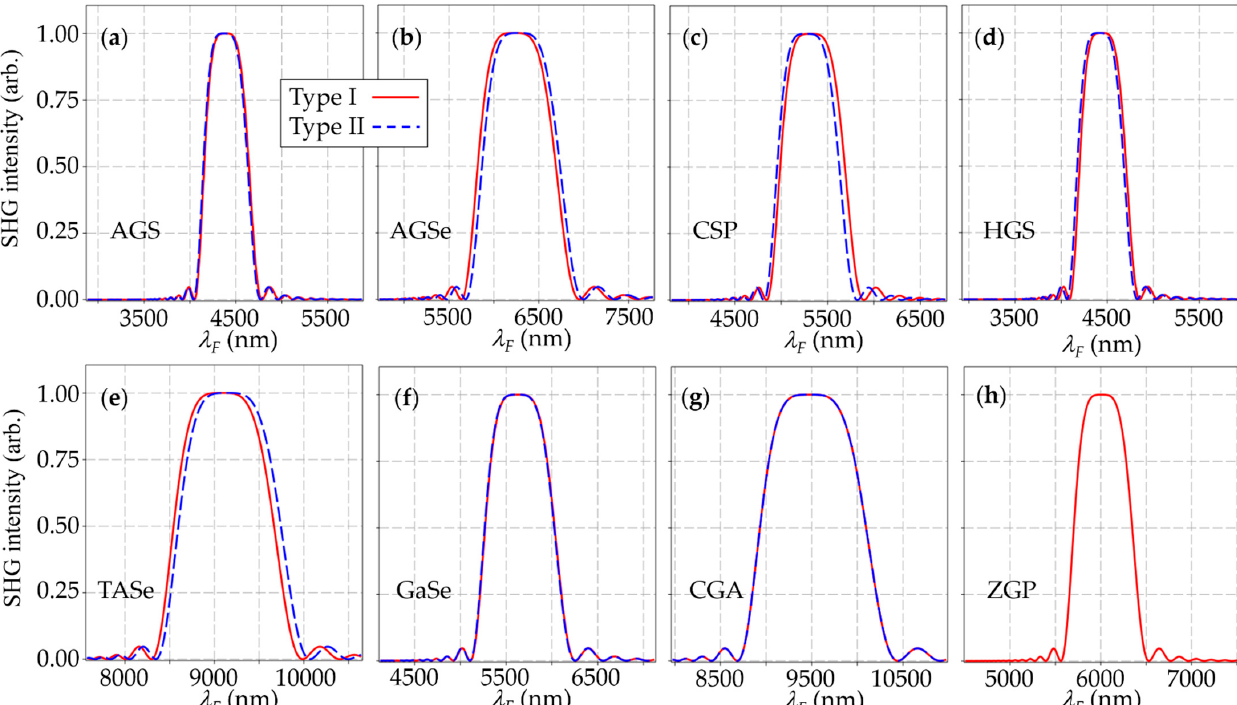
Figure 6. The spectra of F-waves that are acceptable for broadband SHG in uniaxial mid-IR crystals: ( a ) AGS, ( b ) AGSe, ( c ) CSP, ( d ) HGS, ( e ) TASe, ( f ) GaSe, ( g ) CGA, and ( h ) ZGP. Solid red line: Type I; dashed blue line: Type II.